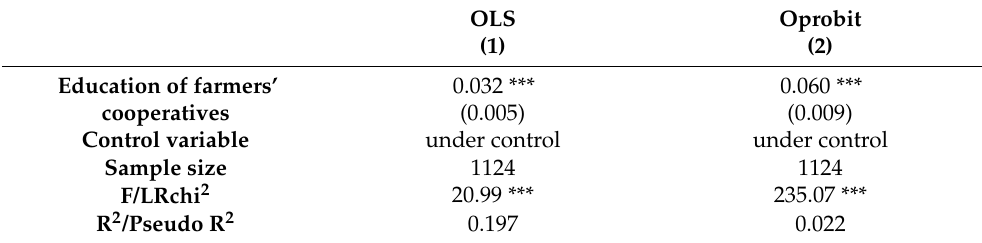
Table 6. Estimated results of the impact of cooperative’s education on members’ cognition of GCT.